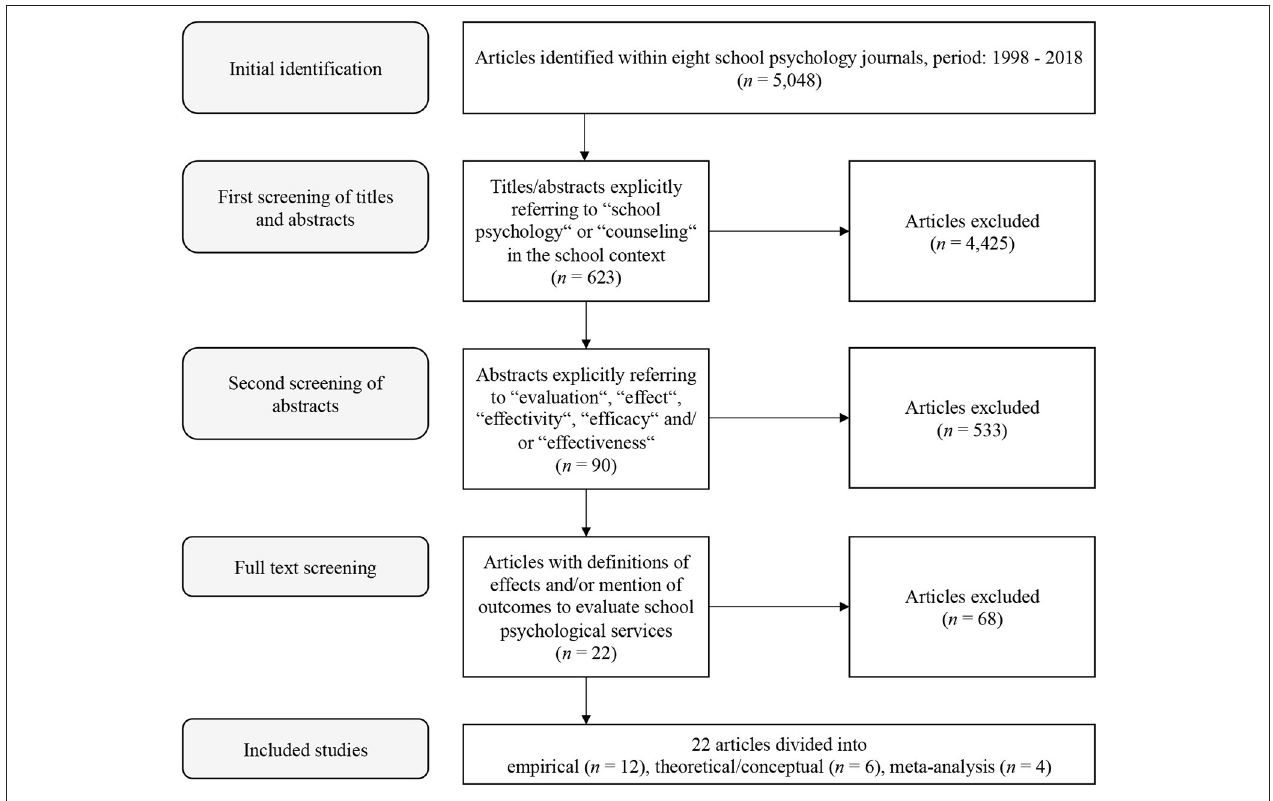
FIGURE 1 | Flowchart of the scoping review